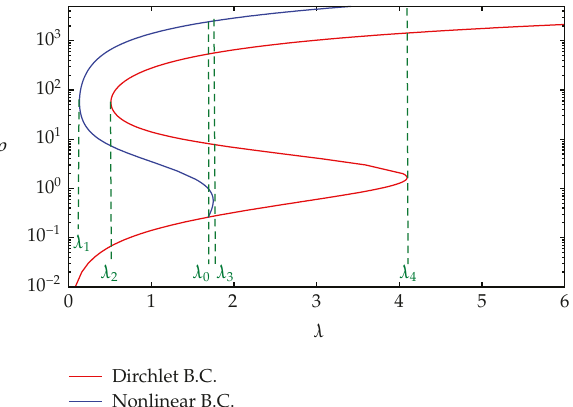
Figure 16: Graph of λ versus ρ for β (cid:3) 8.